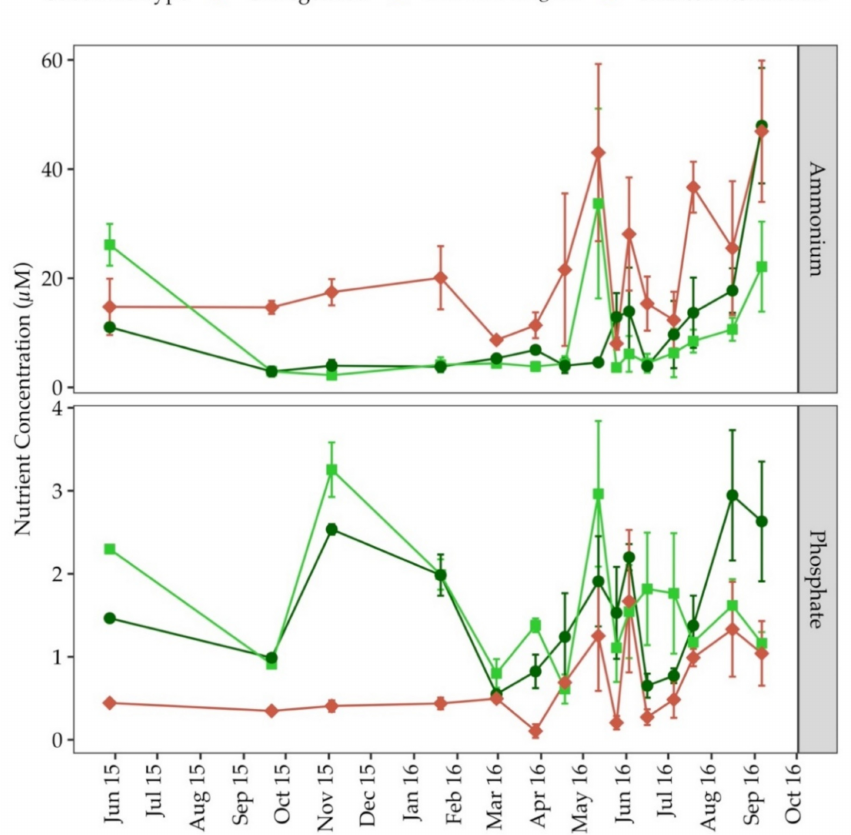
Figure 4. Porewater ammonium (top panel) and phosphate (bottom panel) in bare sediments, colonized by H.wrightii and T. testudinum from May 2015 to September 2016 at Big Sabine Point. Error bars represent standard error of the